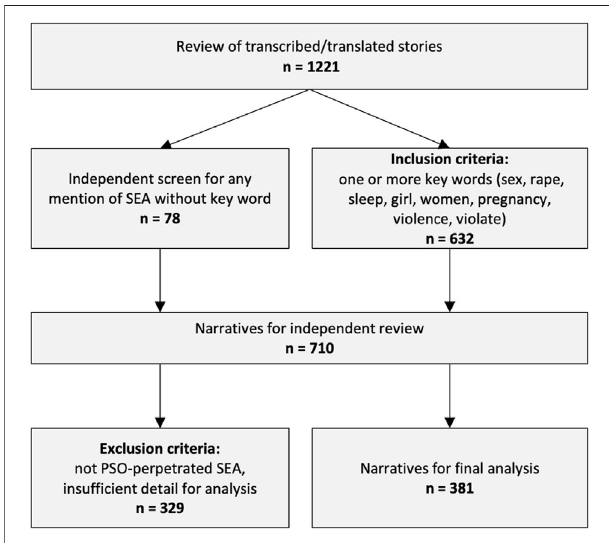
FIGURE 1 | Narrative sampling